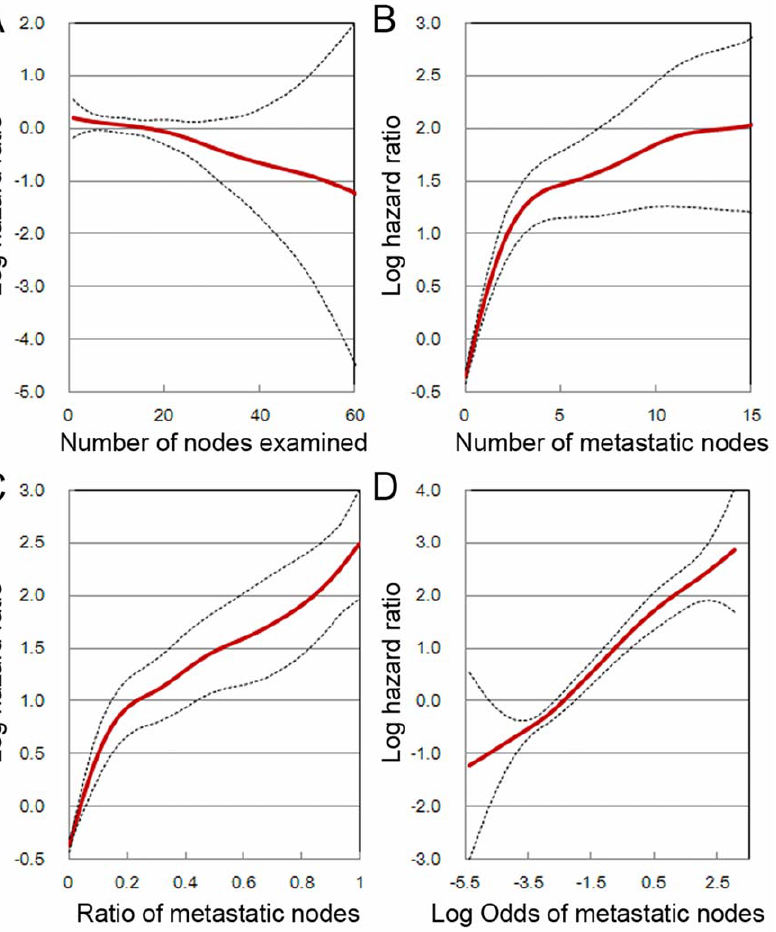
Figure 2. In fitting spline models, colorectal cancer mortality as a function of different classifications. Dotted lines indicate the 95% confidence interval.